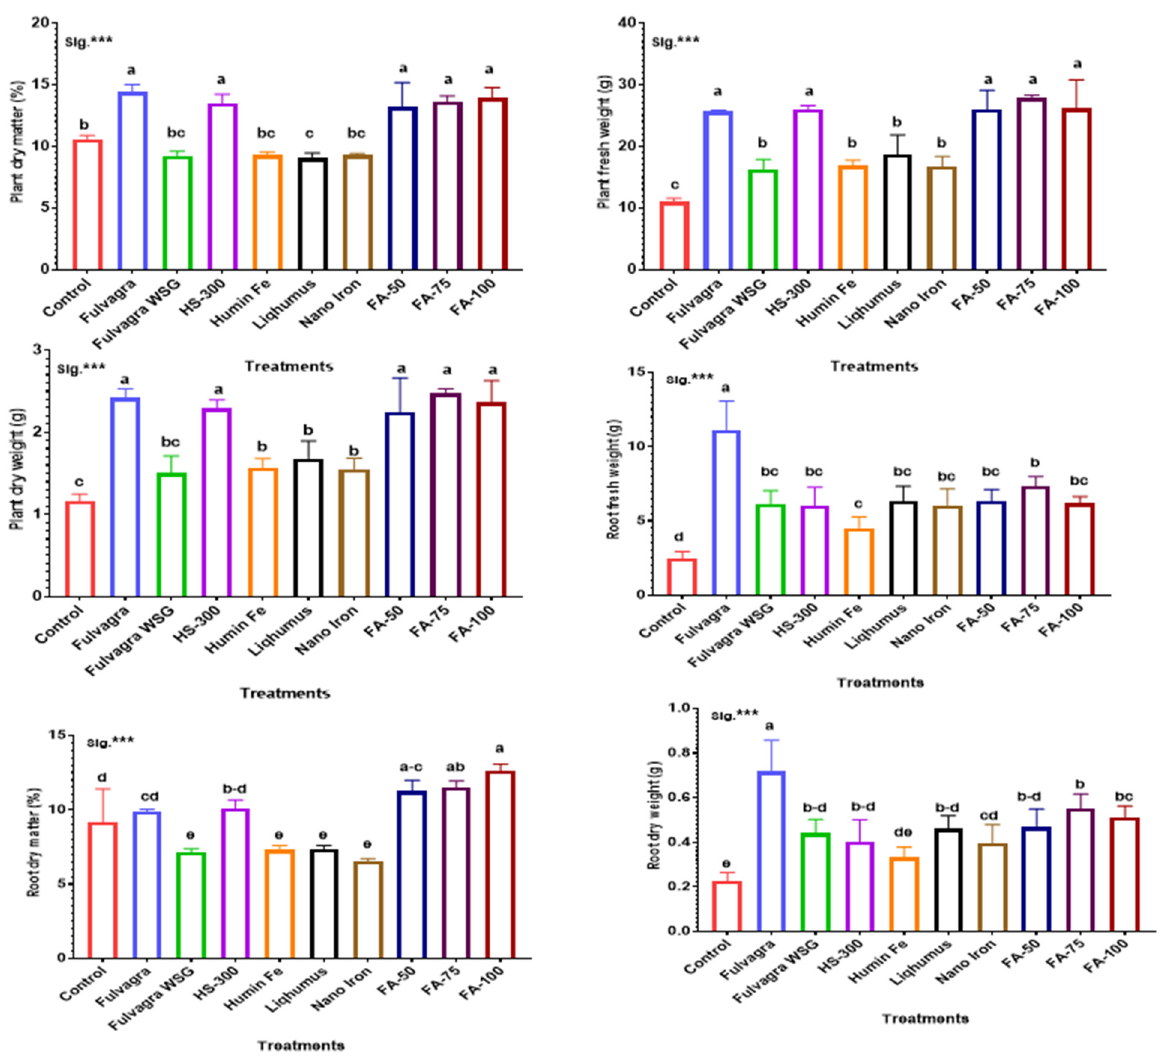
Figure 3. The effects of different treatments on plant fresh weight, plant dry weight, plant dry matter content, root fresh weight, root dry weight, and root dry matter content of spinach. Treatments Fulvagra, Fulvagra WSG, HS-300, Humin Fe, and Liqhumus contain FeSO 4 ·7H 2 O; treatments Nano Iron, FA-50, FA-75, and FA-100 contain nano ferrihydrite. The iron concentration in all treatments is 20 mM. The mean values with the same letter within the same column are not significantly different (***: p > 0.001).